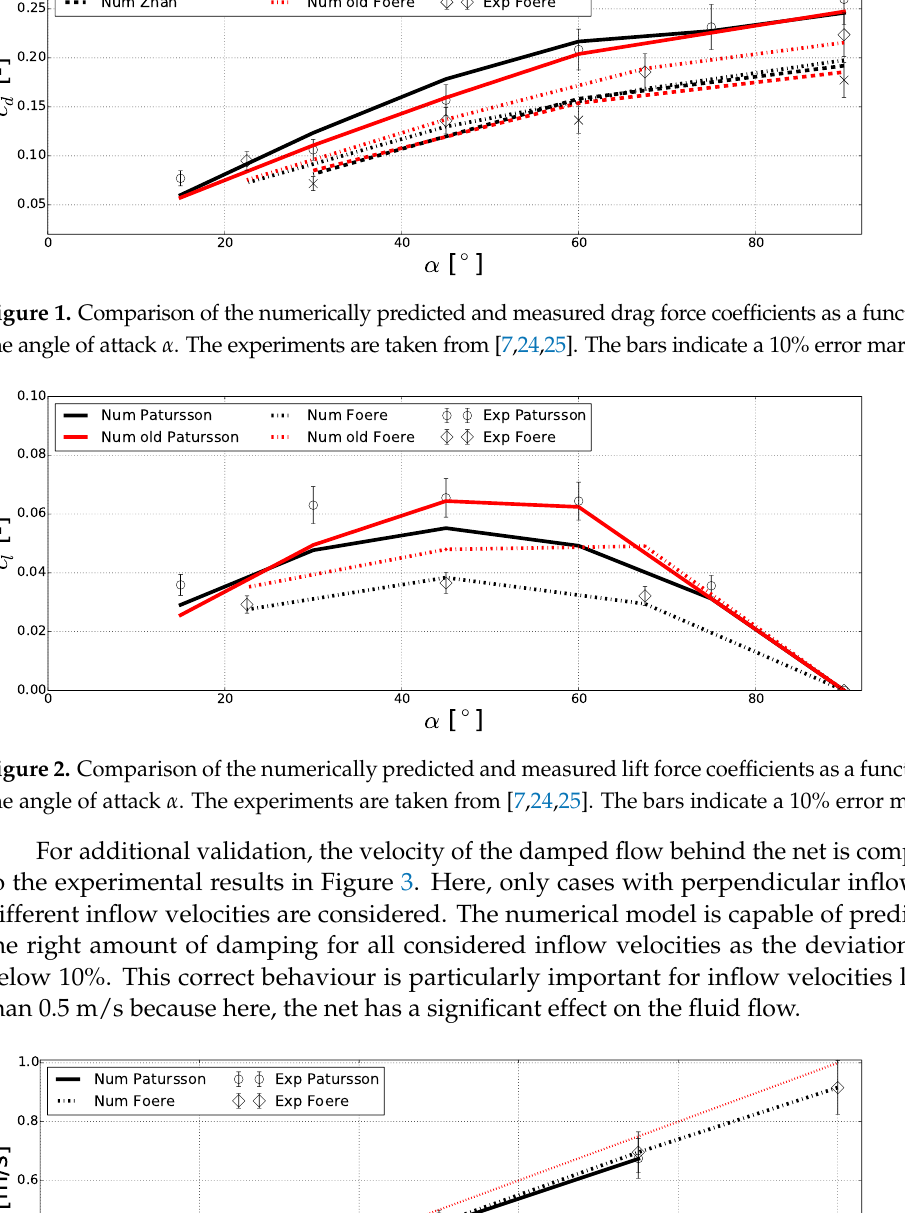
which is a sufficient result.